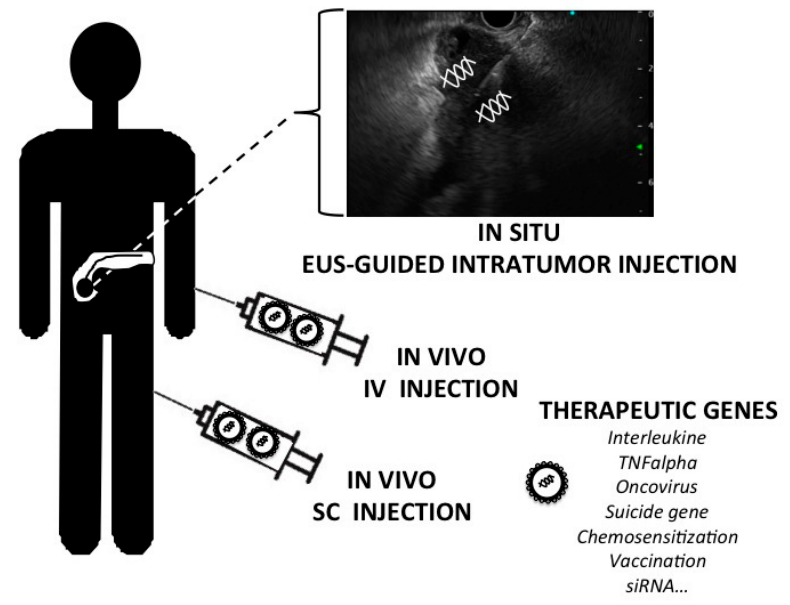
Figure 1. Clinical approaches of gene therapy for pancreatic cancer: type of gene therapy and routes of administration, main therapeutic genes. (EUS: endoscopic ultrasound; IV: intravenous; SC: subcutaneous). Table 3. Main published clinical trials of gene therapy for pancreatic cancer.